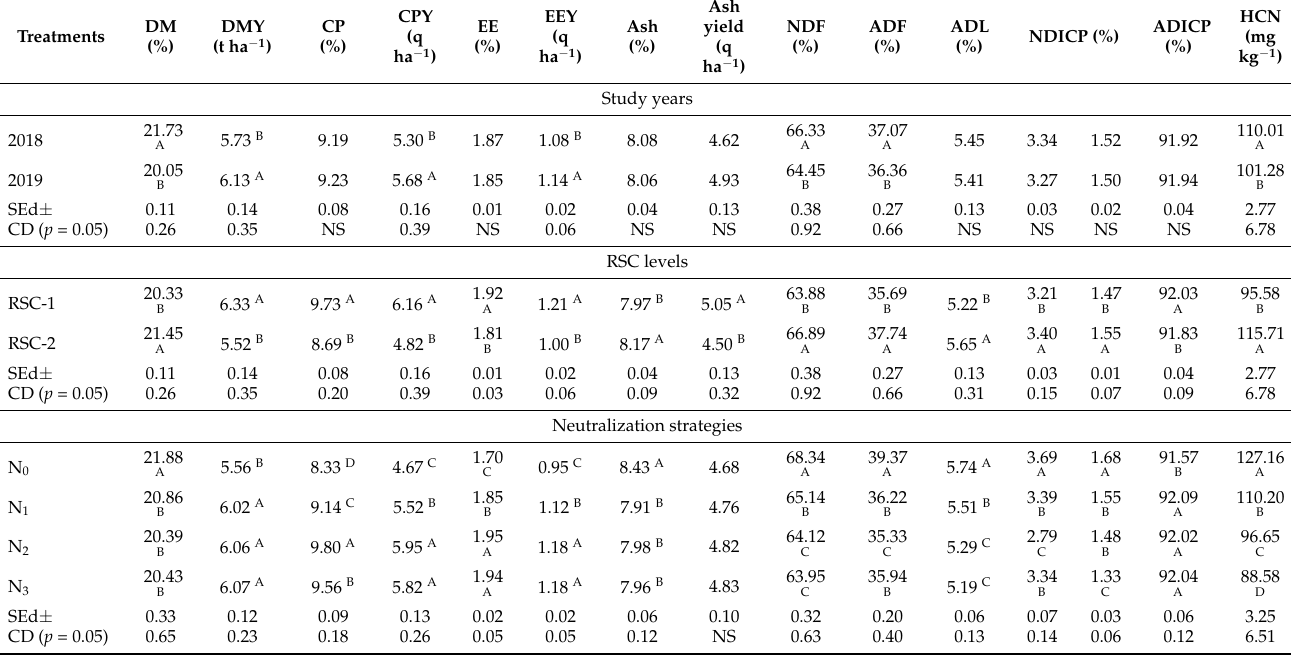
Table 3. Fodder quality traits of summer sorghum as influenced by study years, RSC levels and neutralization